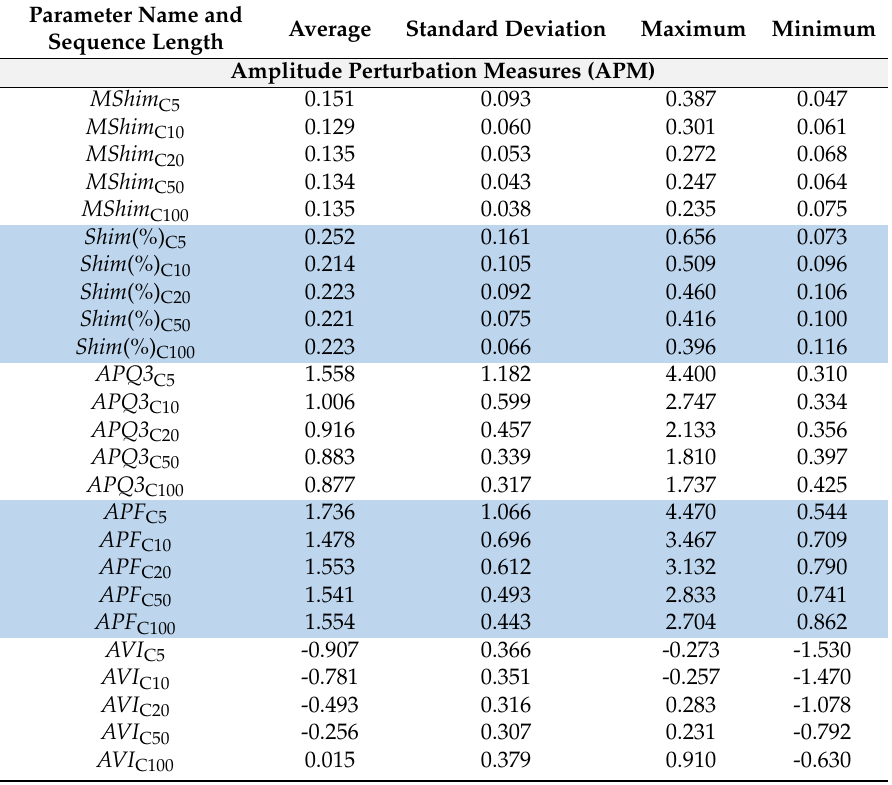
Table A2. Group values of all parameters for Amplitude Perturbation Measures (APM).